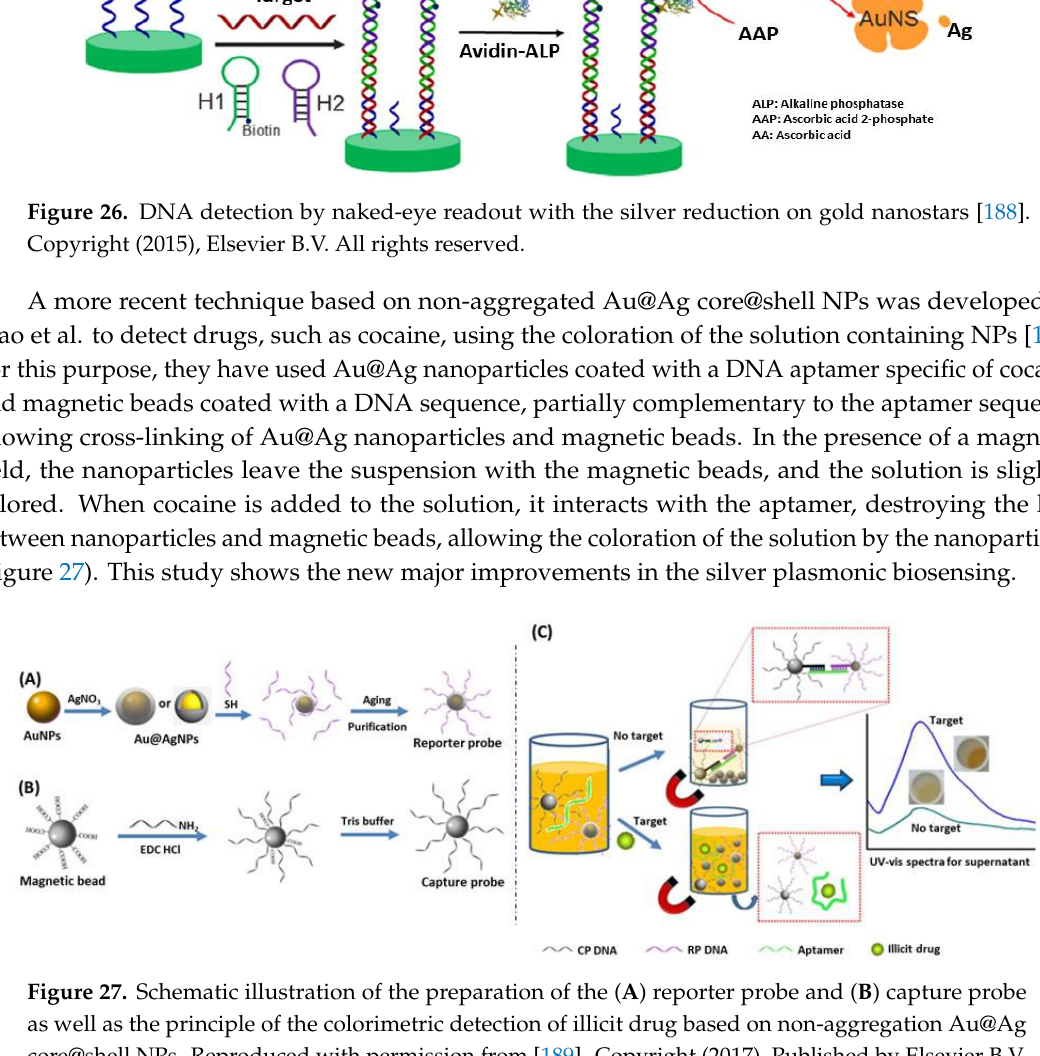
Figure 27. Schematic illustration of the preparation of the ( A ) reporter probe and ( B ) capture probe as well as the principle of the colorimetric detection of illicit drug based on non-aggregation Au@Ag core@shell NPs. Reproduced with permission from [189]. Copyright (2017), Published by Elsevier B.V.